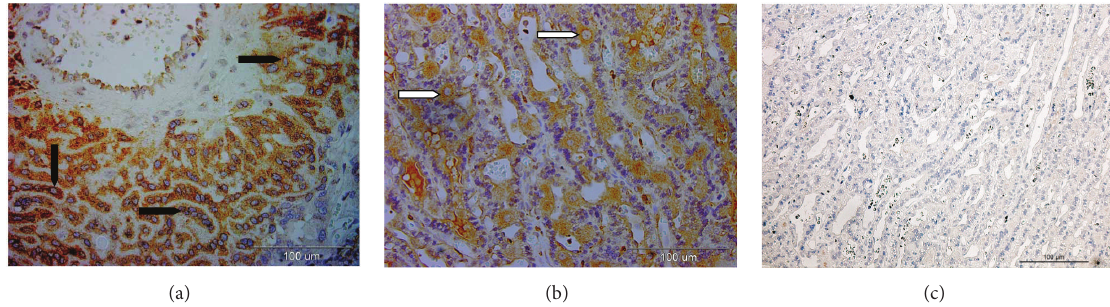
Figure 4: PTGS2 protein localization in the placenta. Immunohistochemical localization of PTGS2 in feline placenta from the 9th week of pregnancy. Positive signals are shown in the strongly invading trophoblast surrounding blood vessels (solid arrowheads) (a) and also in maternal decidual cells (open arrowheads) (b). (c) Isotype control.